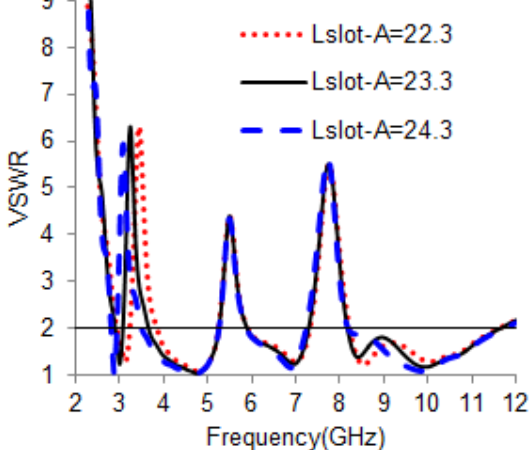
Figure 7: (a) VSWR curve for variation in length of slot-A for proposed Antenna-D.